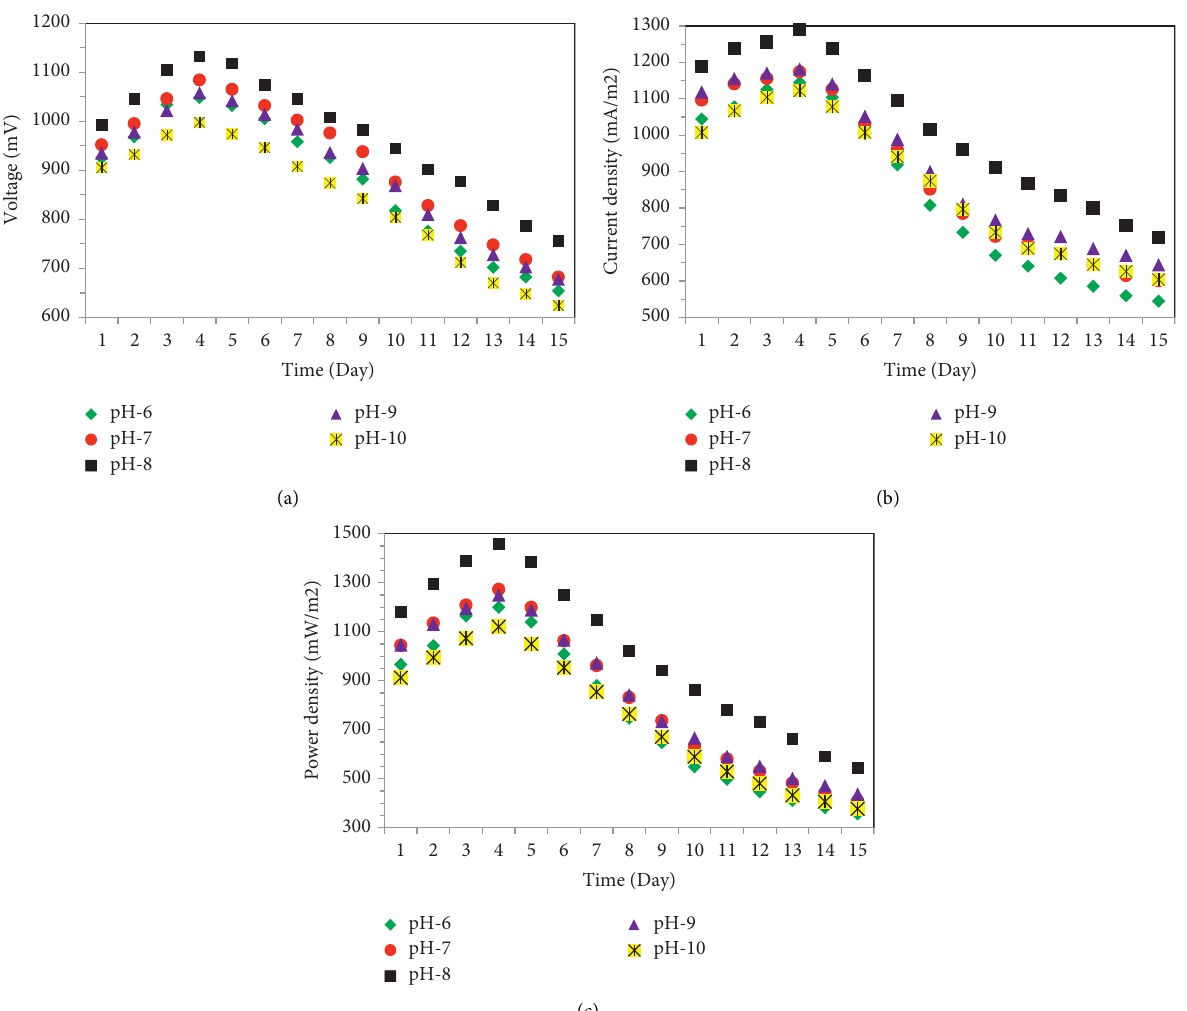
Figure 4: Effect of pH on the (a) generated voltage, (b) current density, and (c) power density by using biomass feed from Bhairab river